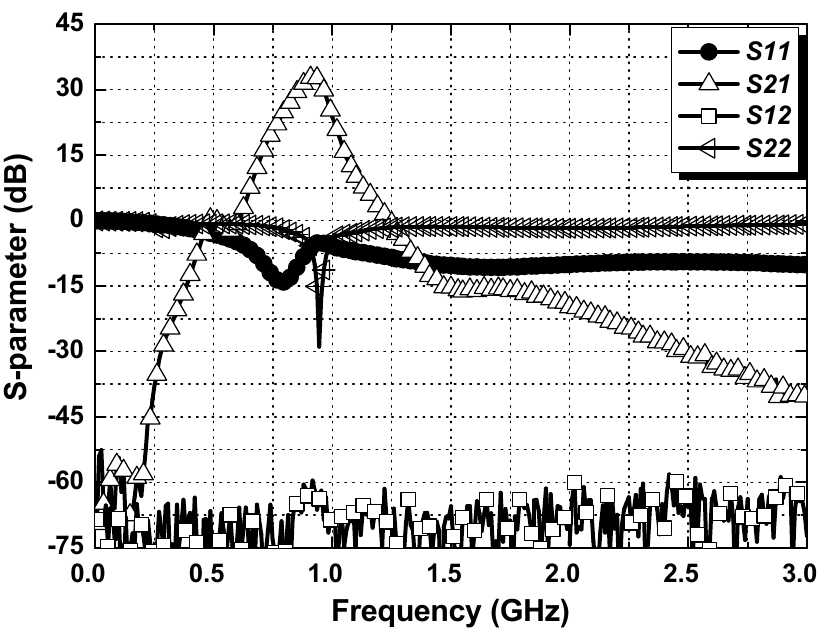
Figure 12. Measured S-parameter performances.